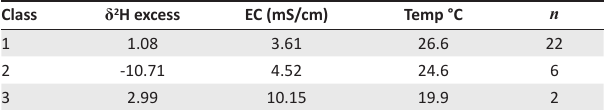
TABLE 2: k -means centroids for groundwater EC (mS/cm), temperature (°C), and δ 2 H excess recorded in the Etosha National Park during May 2013.